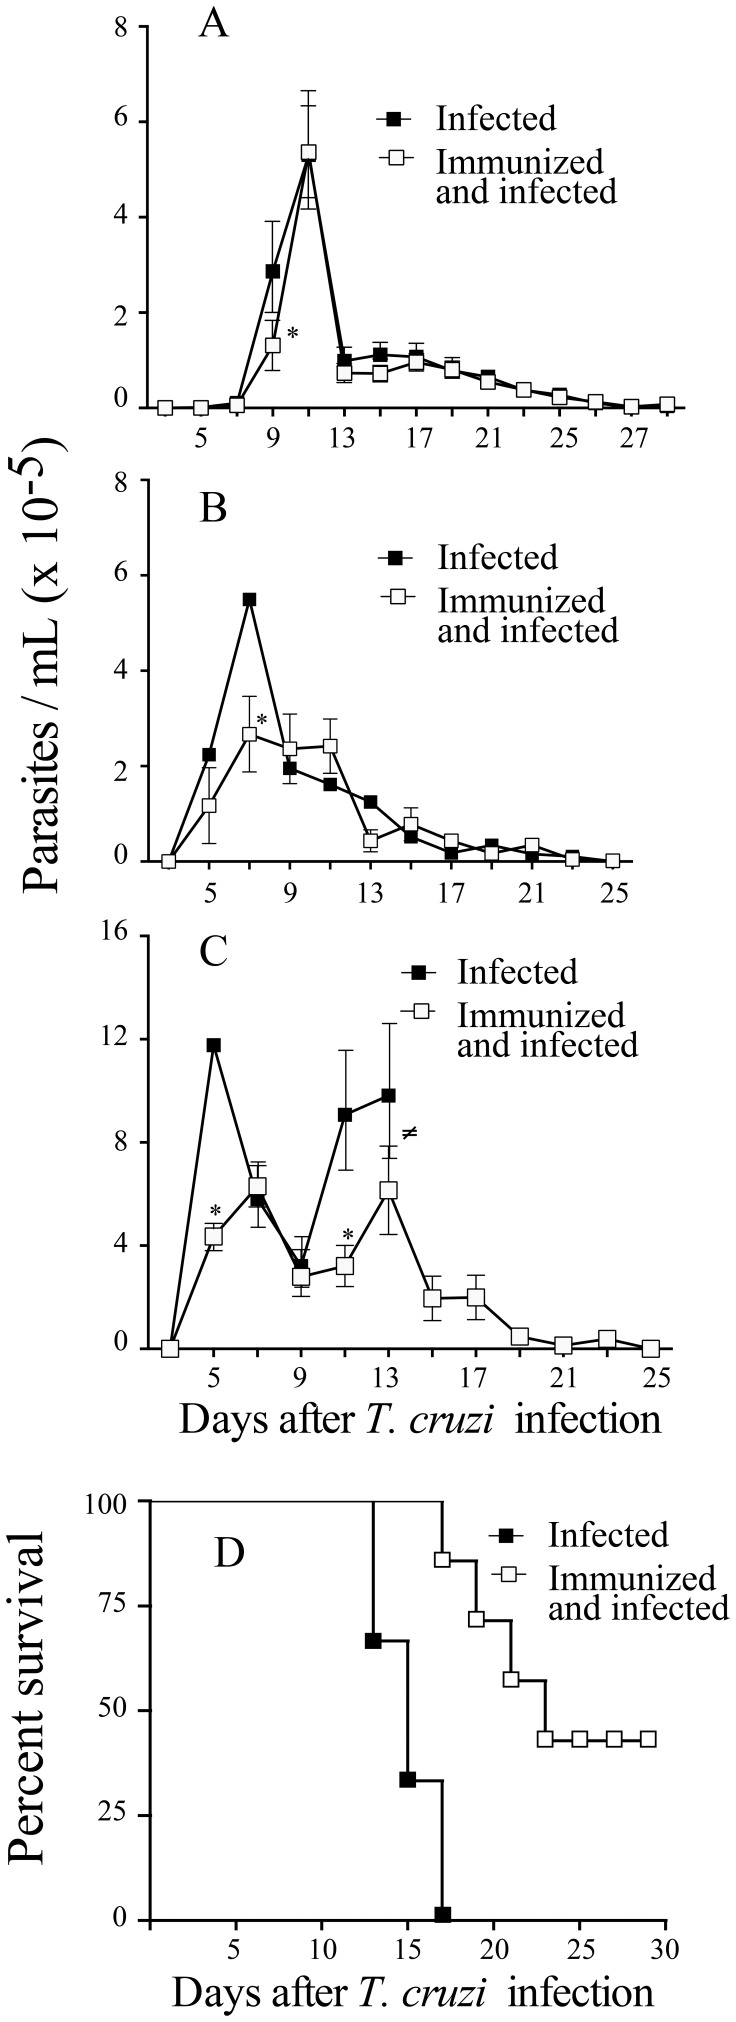
Oral exposure to P.
serpens decreases parasitemia and mortality in response to T. cruzi infection.C57BL/6 mice were immunized with P. serpens (2×108 living parasites per 0.1 mL PBS administered by gavage) four times with one-week intervals. Seven days after the last immunization mice were infected with Y strain of T. cruzi, A: 102, B: 5×103 and C: 105 trypomastigote forms, respectively. Parasitemia were assessed over 30 days post infection. D: Survival of immunized mice and infected with 105 (lethal dose). Data are represented as mean ± standard error represented of at last 10 mice per group. Asterisks indicates significant differences (p<0.05). (≠) indicates that all animals died.